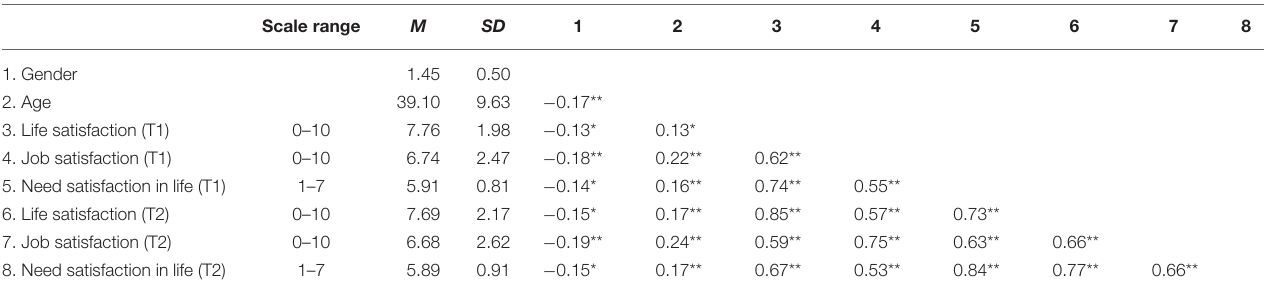
TABLE 6 | Descriptives and inter-correlations between all study 3 variables, at Time 1 (T1) and Time 2 (T2) (longitudinal data). Scale